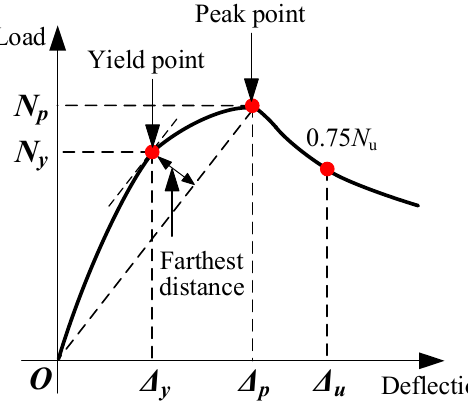
Figure 13. Farthest point method. Table 5. Ductility coefficient of test